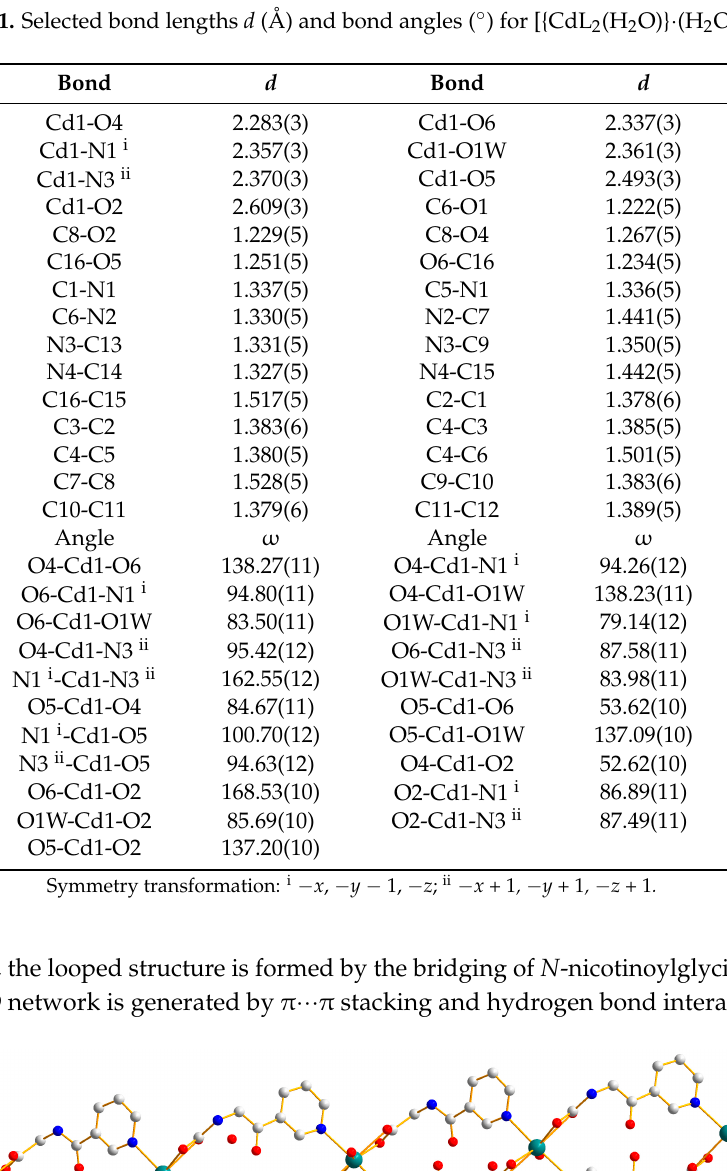
Table 1. Selected bond lengths d (Å) and bond angles ( ◦ ) for [{CdL 2 (H 2 O)} · (H 2 O) 3 ] n . Bond